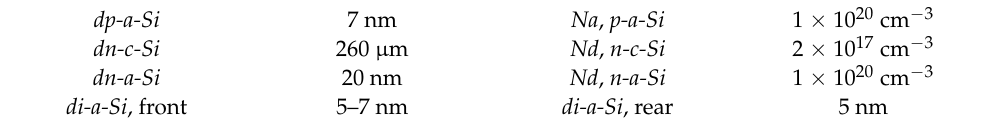
Table 1. Optimized parameters of the HIT solar cells simulated using the AFORS-HET tool [45]. dp-a-Si